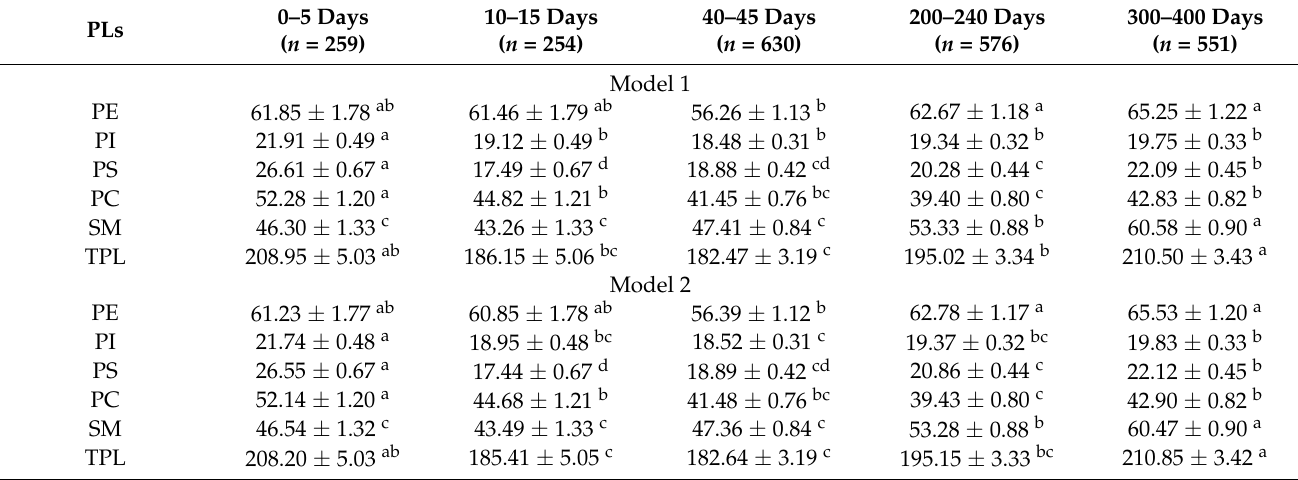
Table 2. Differences of TPL and sub-class PLs concentration in human milk over lactation (mg/L).